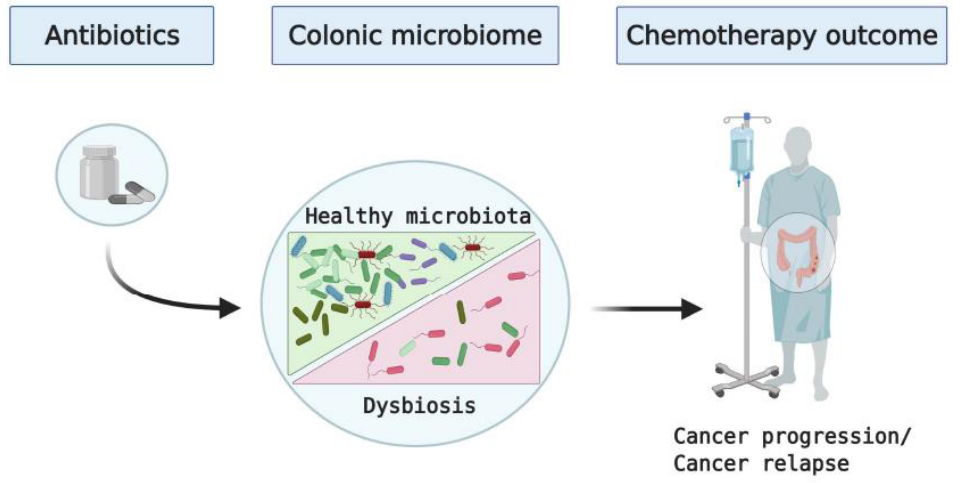
Figure 1. Schematic outlining potential impact of antibiotic use on the colonic microbiota and outcomes of chemotherapy in patients with colon cancer.